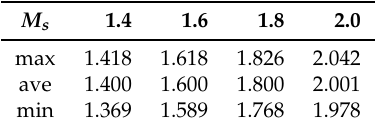
Table 4. Evaluation of | M s − M d s | in the servo mode.